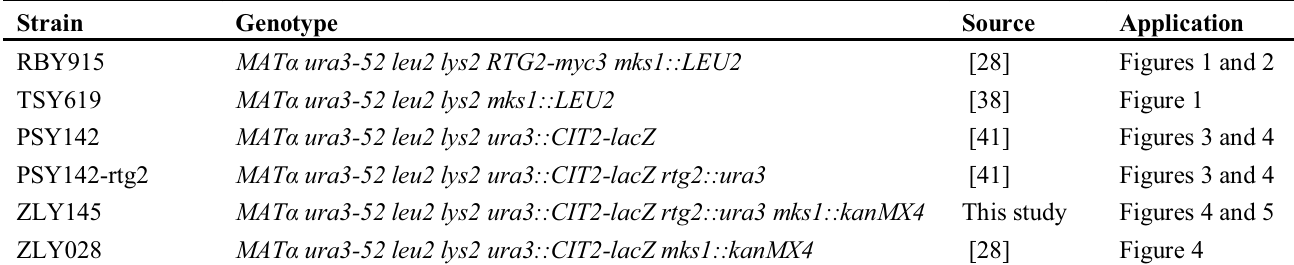
Table 1. Strains used in this